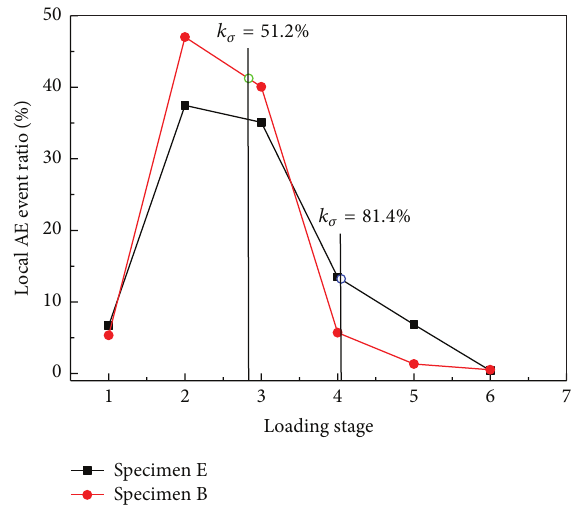
Figure 11: The ratio of AE events of different loading